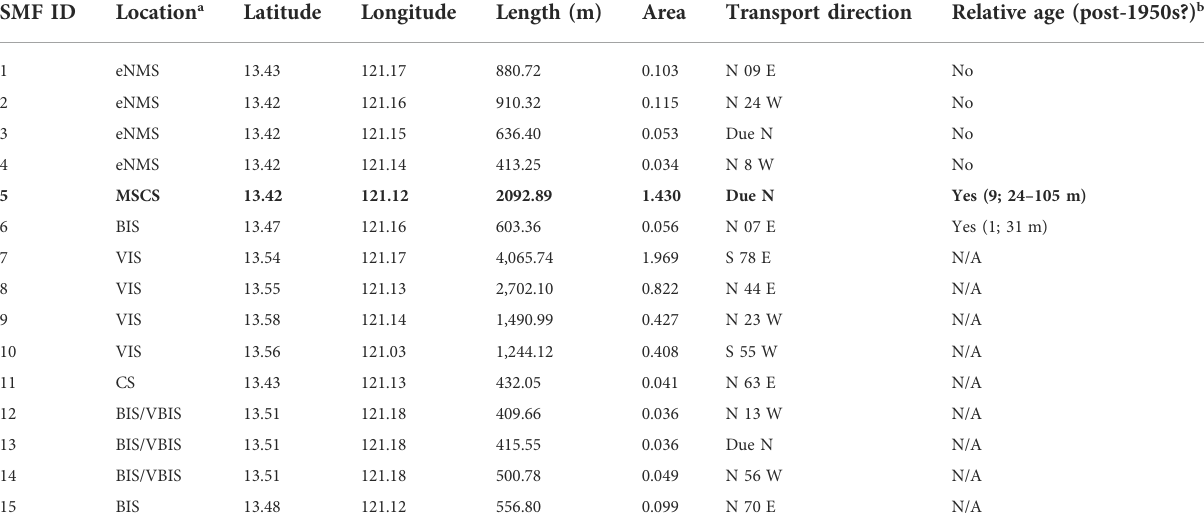
TABLE 4 The 15 mapped probable SMFs in the South